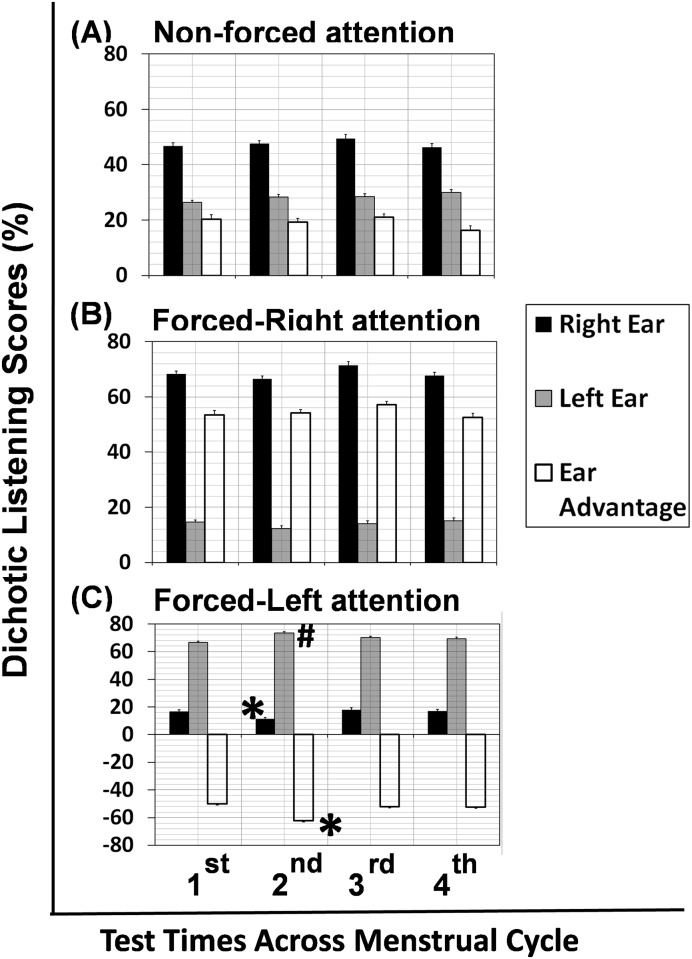
Ear scores and ear advantage across the menstrual cycle in different attention conditions.Error bars are standard errors. The symbol * shows the score at the 2nd test time to be significantly different from that at the other three test times, while the symbol # indicates the score at the 2nd test time to be significantly different from that at the 1st test time.